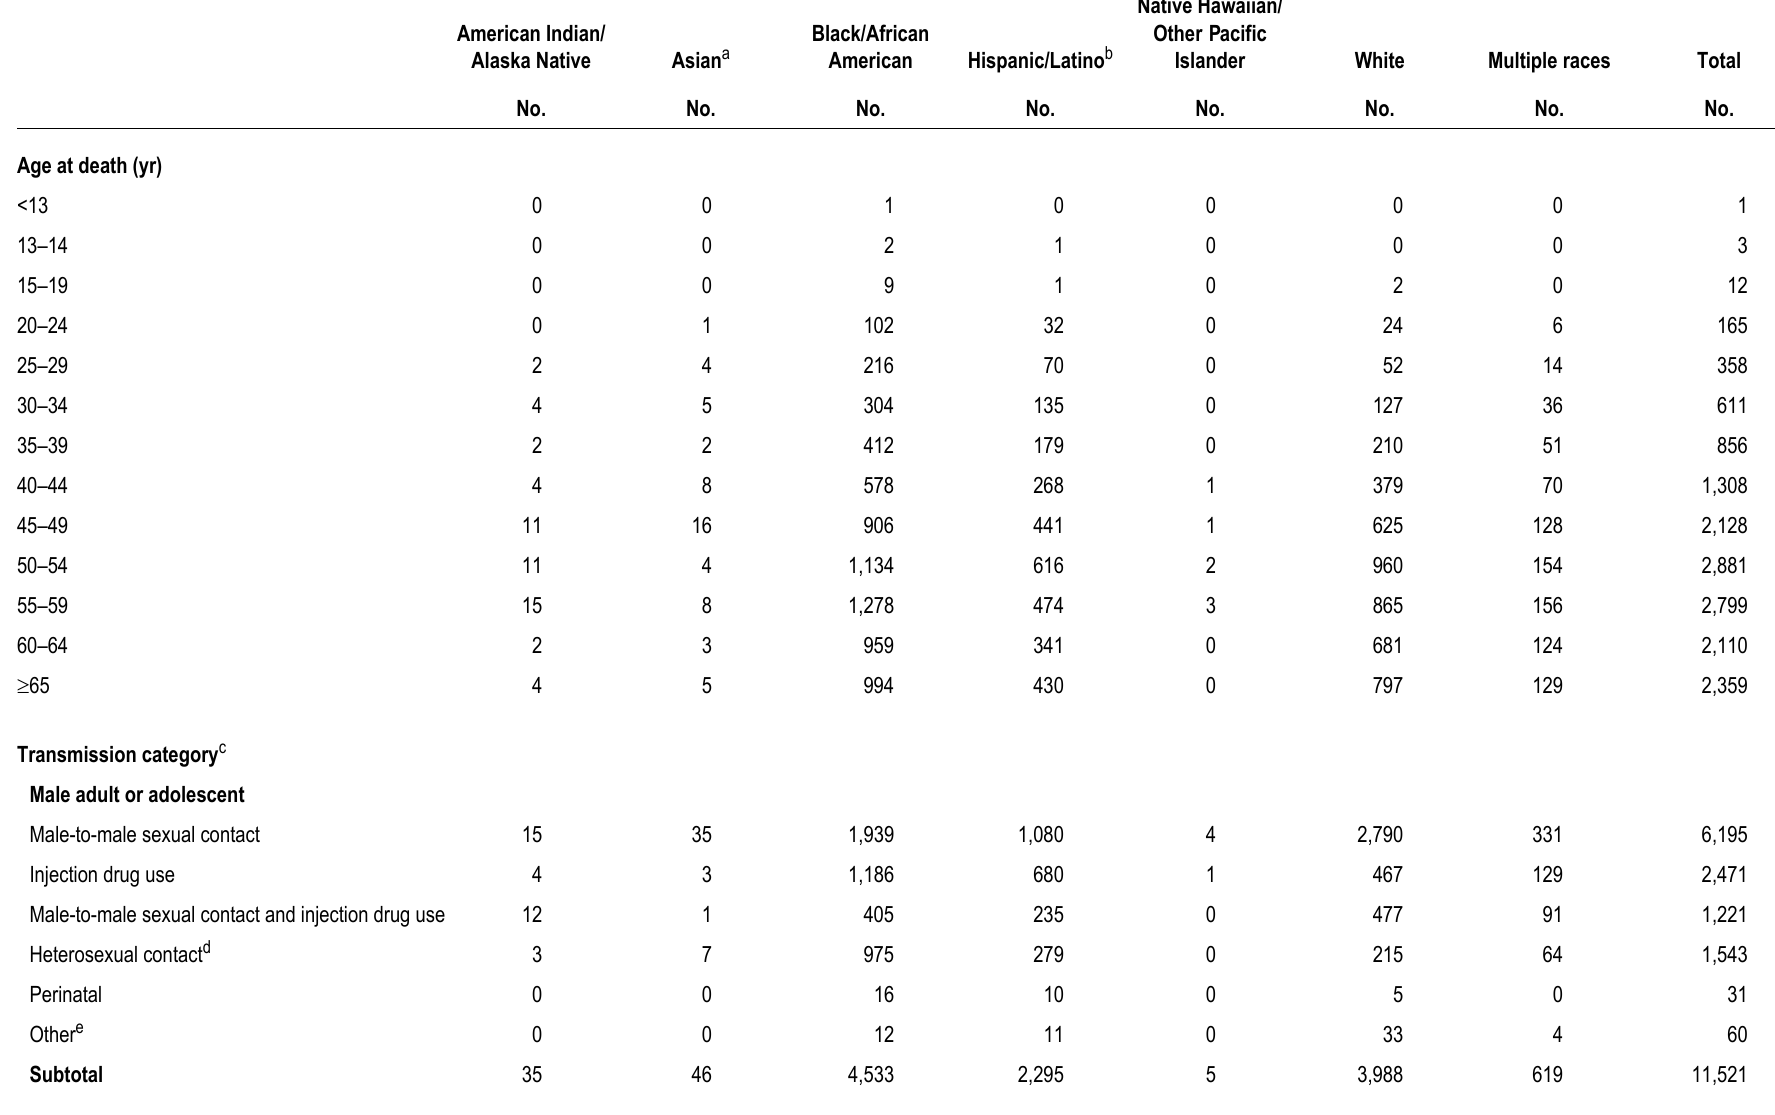
Table 14b. Deaths of persons with diagnosed HIV infection, by race/ethnicity and selected characteristics, 2014—United States and 6 dependent areas